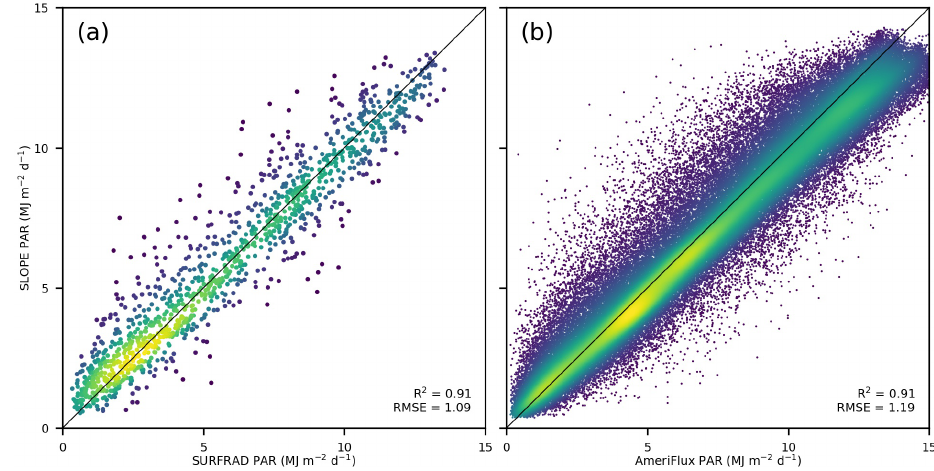
Figure 3. Comparison between site-observed PAR and SLOPE PAR. (a) Comparison across seven SURFRAD sites in 2019. (b) Comparison across 41 AmeriFlux sites from 2000 to 2014. All site data are independent of the training